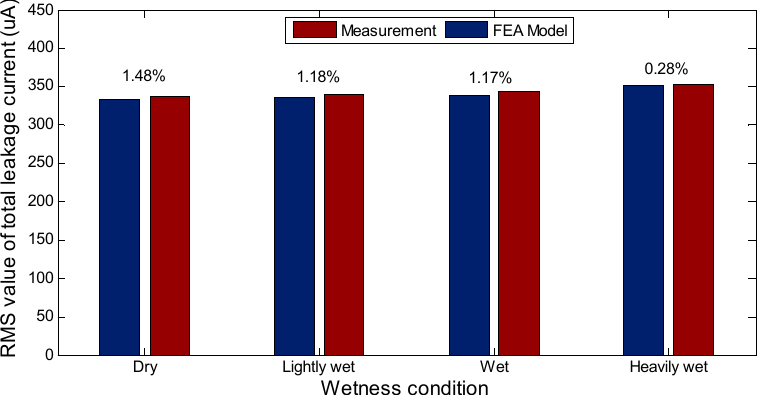
Figure 9. RMS value of the total leakage current between measurement and FEA model under different wetness conditions at 8 kV rms .